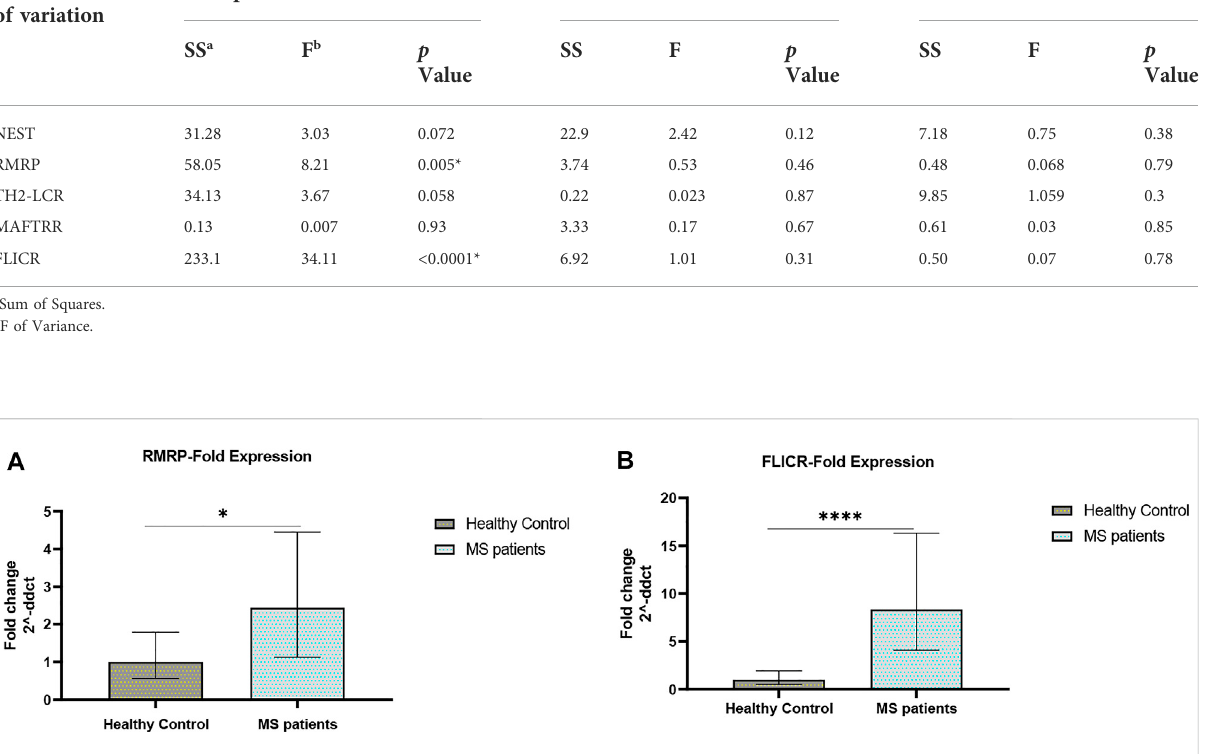
TABLE 4 Graphpad prism output from analysis of effect of Group and Gender (Tests of Between-Subjects Effects) on expression of studied genes in cases compared to healthy controls. Source Group effect Gender effect Interactions of variation